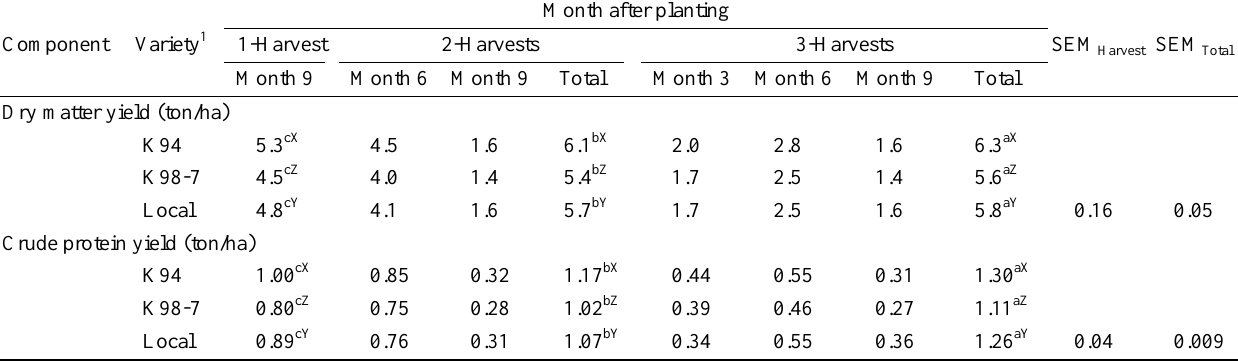
Table 1. Dry matter and crude protein yield of three varieties of cassava foliage with a three-, two- or one harvest system at 3, 6 or 9 months after planting